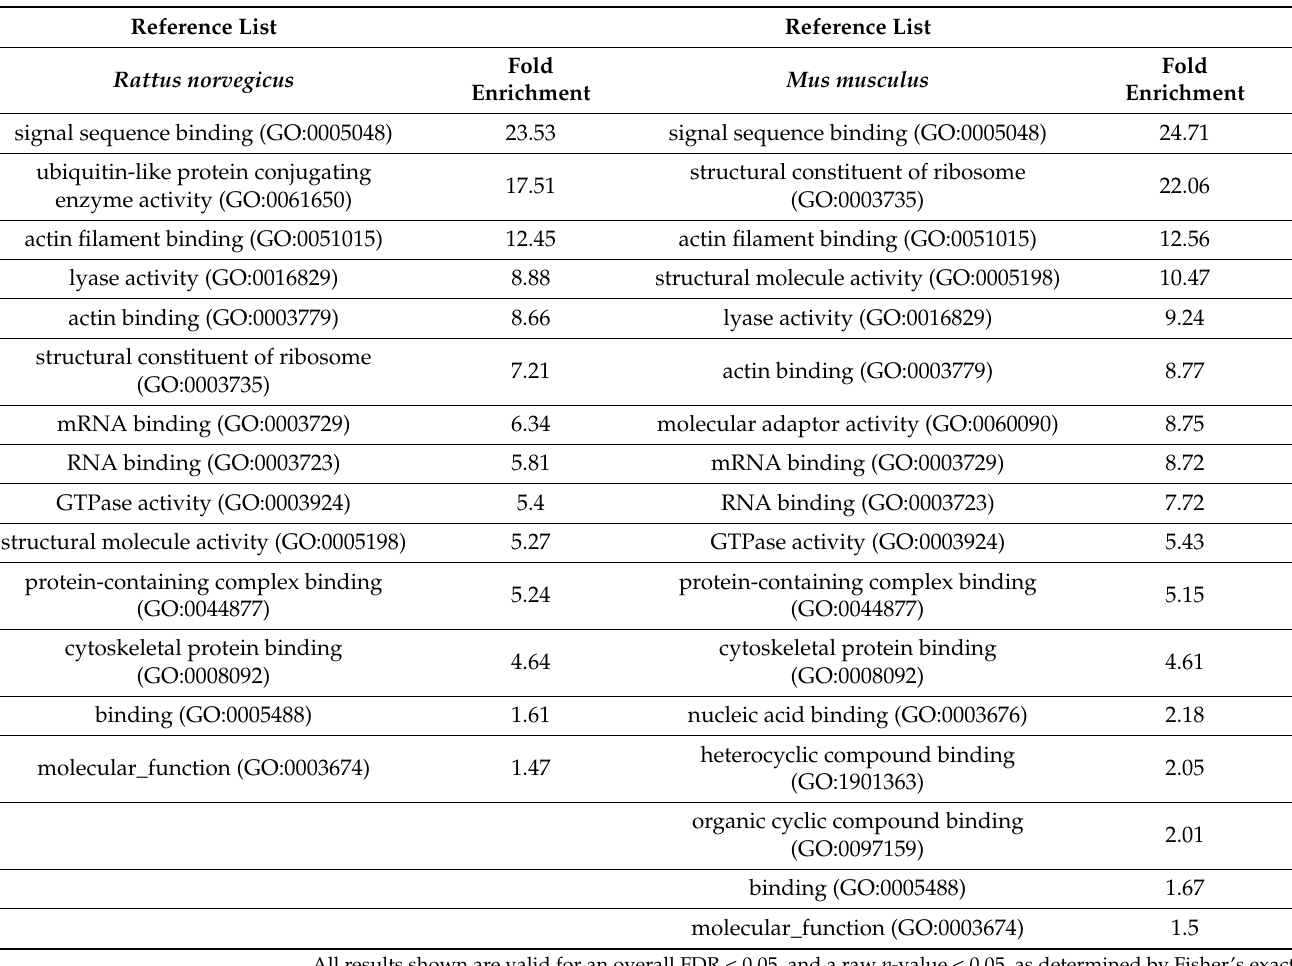
Table 3. PANTHER GO-Slim molecular function